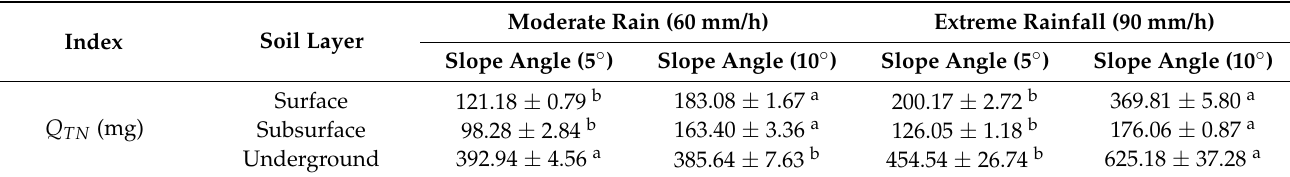
Table 2. TN loss per hour per square meter of sloping farmland.